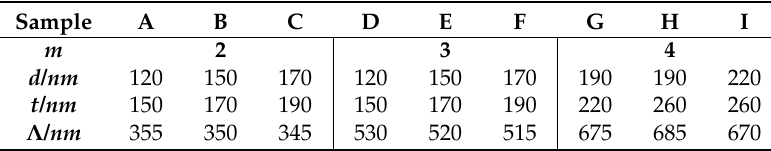
Table 2. Design parameters for the nine DFB polymer laser cavities.